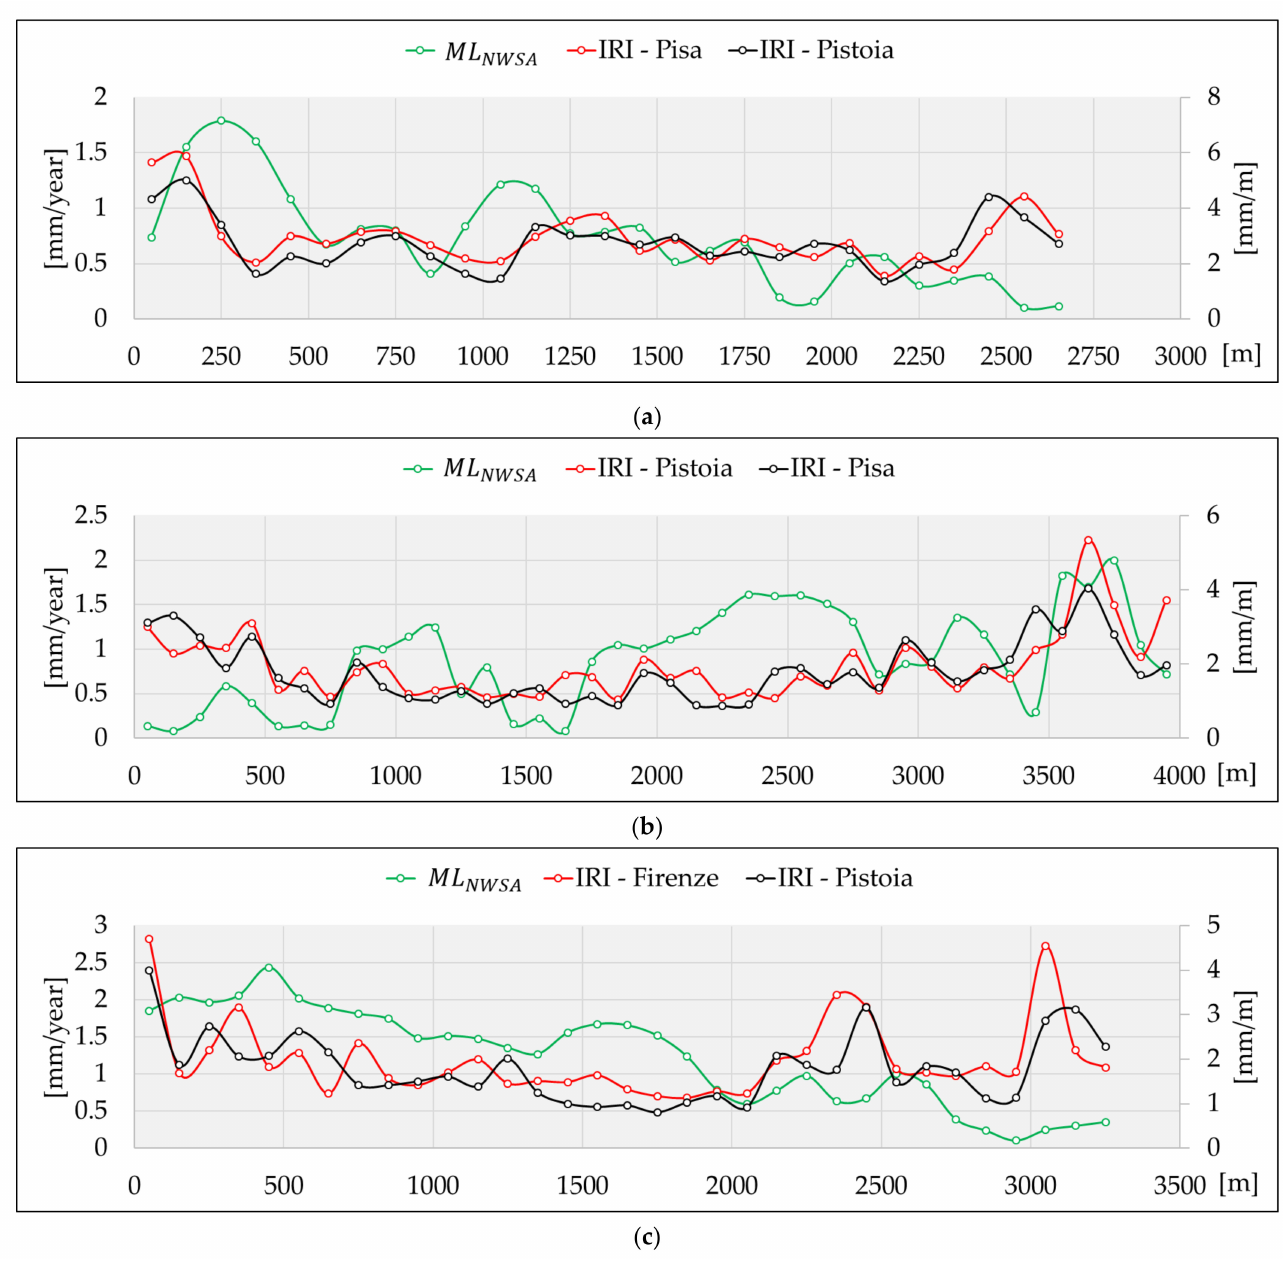
Figure 15. Comparison between IRI and the normalized weighted sum of the absolute value of ML predictions: ( a ) test site 1, ( b ) test site 2, and ( c ) test site